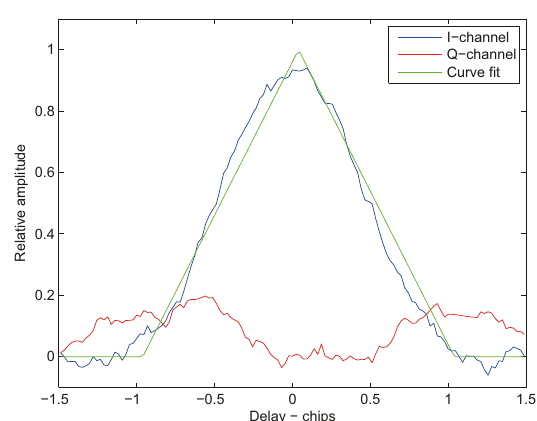
Figure 2: Tacking loops